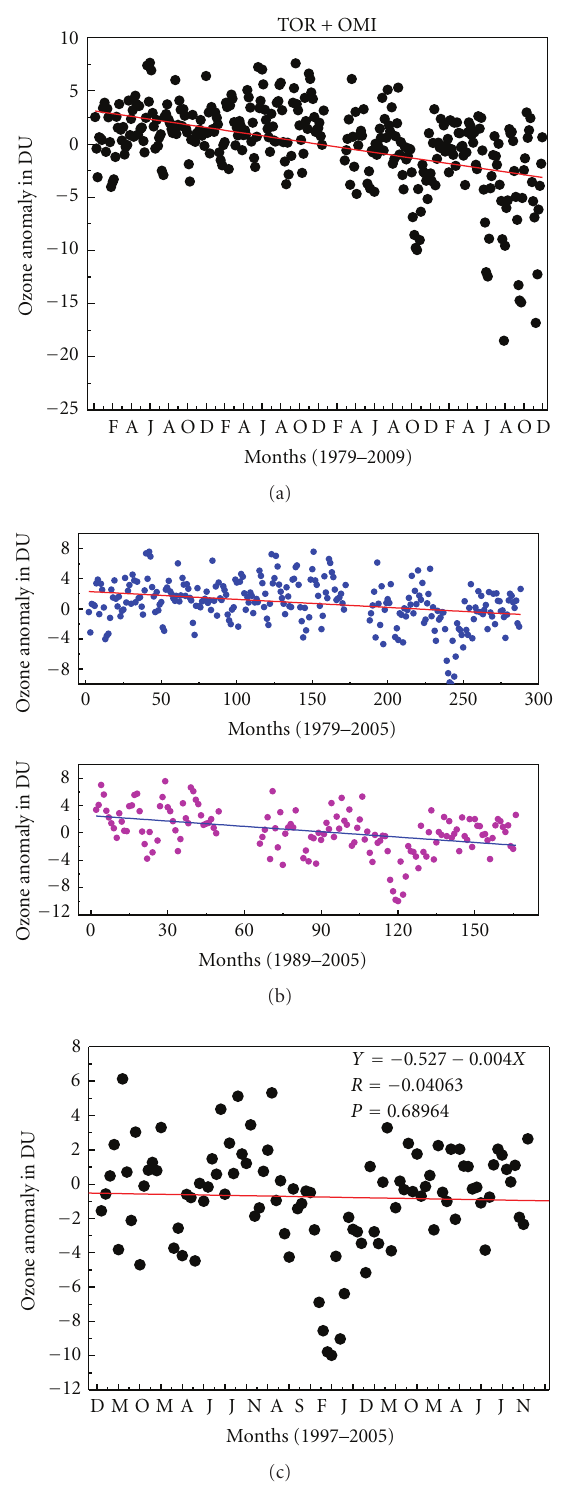
Figure 9: (a) Scatter plot of monthly normalized tropospheric ozone over NE for the entire period 1979–2009. The solid line is the linear regression through the points. (b) Scatter plot of normalized monthly tropospheric O 3 over NE as obtained using only TOR data for the period 1979–2005 (top) and 1989–2005 (bottom). (c) Scatter plot of normalized monthly tropospheric O 3 over NE as obtained using TOR data only for the period 1997–2005.